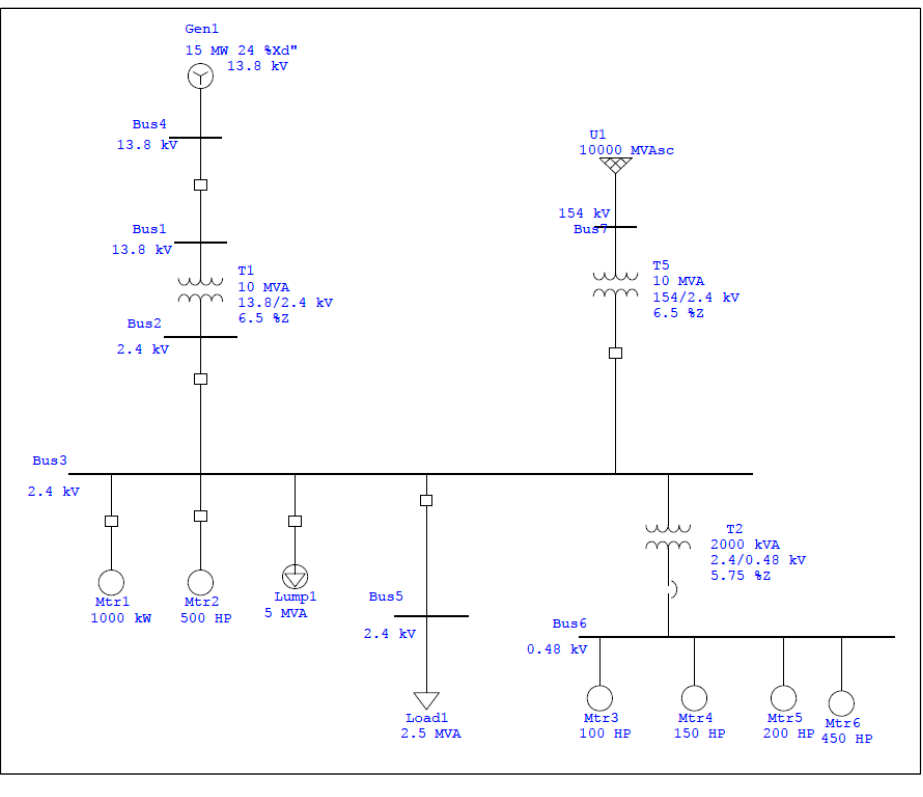
Figure 7. System simulation circuit.